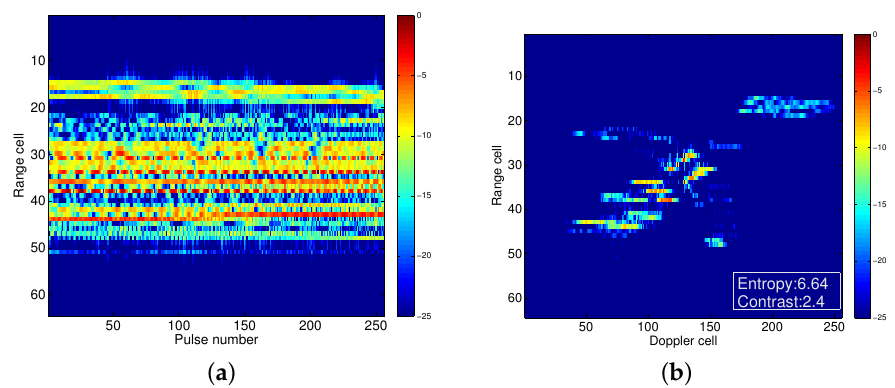
Figure 8. HRRPs and RD image. ( a ) HRRPs. ( b ) ISAR image based on RD algorithm.